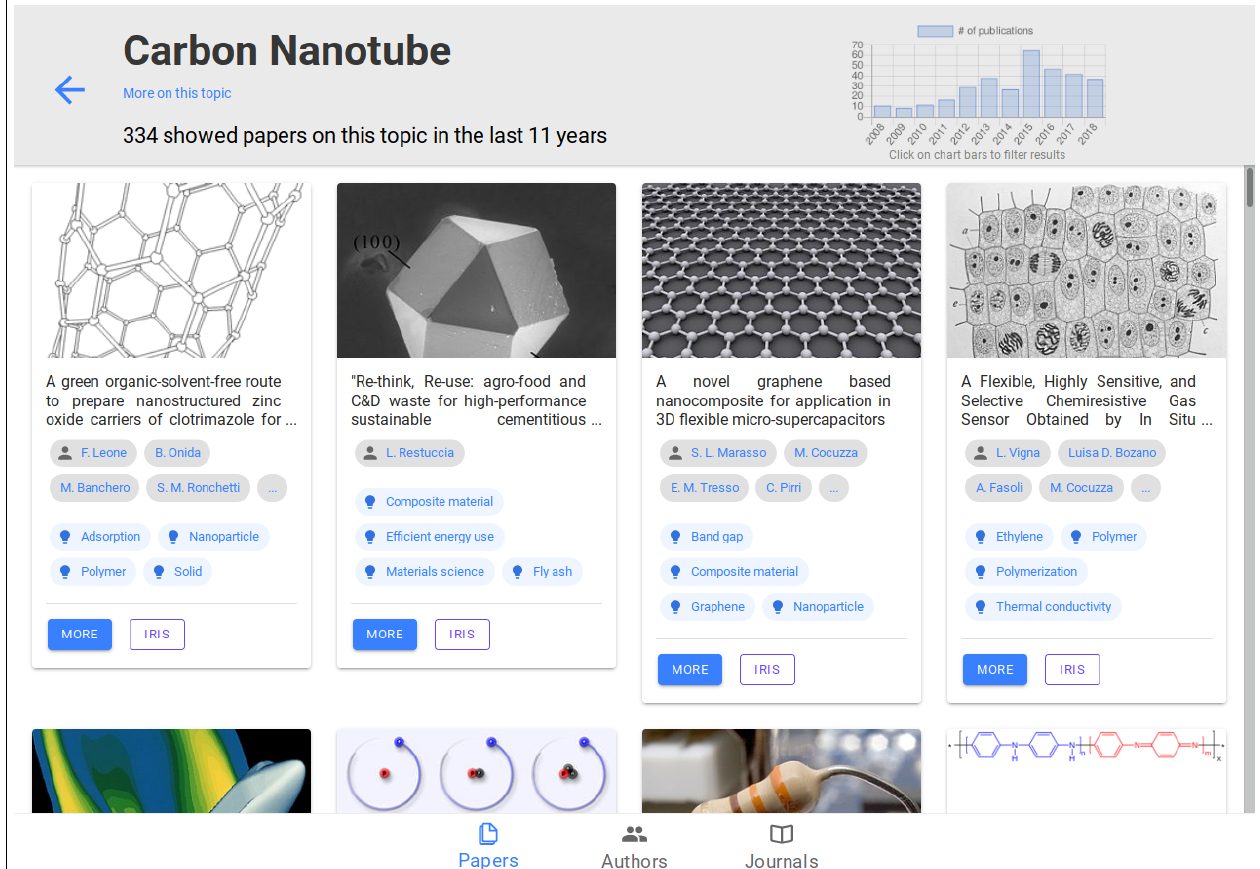
Figure 4. Screenshot of the Geranium Web App: results of the topic-based